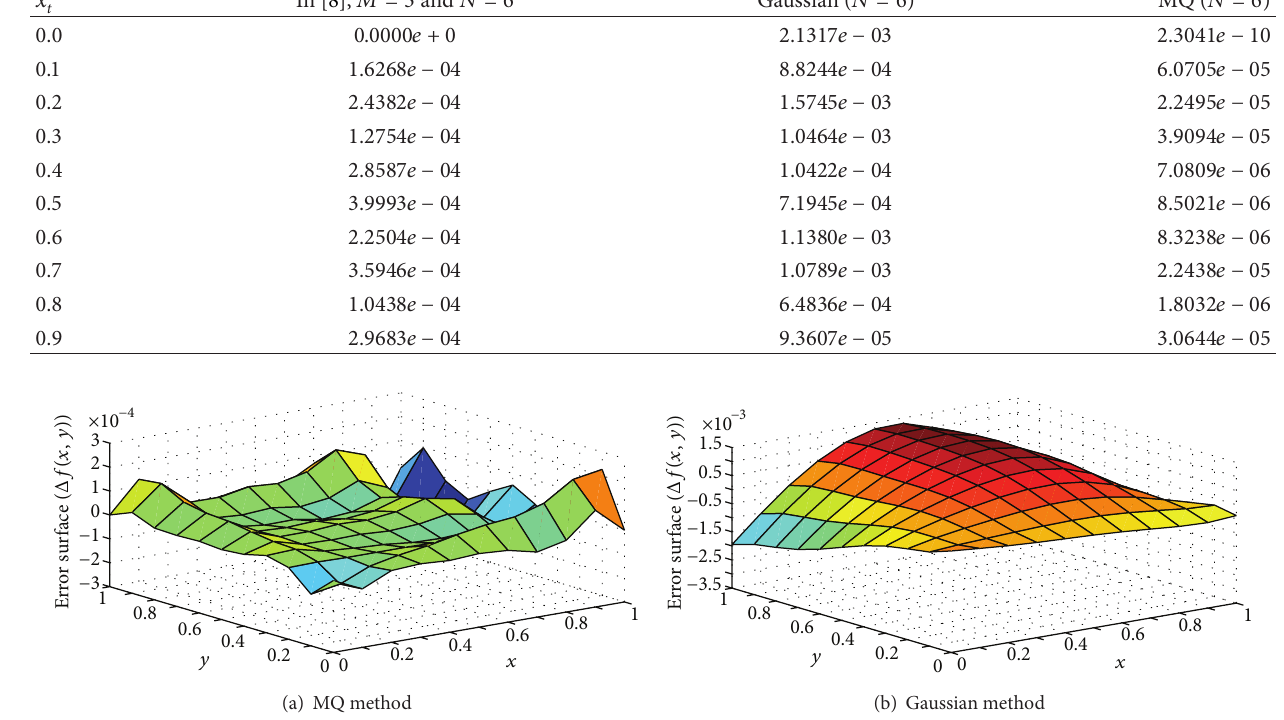
Table 3: The absolute error comparison among HBT [8], Gaussian, and MQ with ℎ = 1/5.